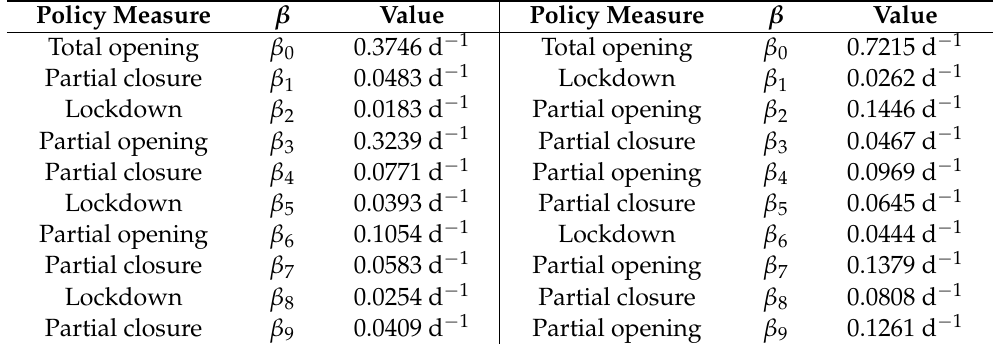
Table 5. GBR (left table) and ISR (right table) function β ( t ) values related to the restriction